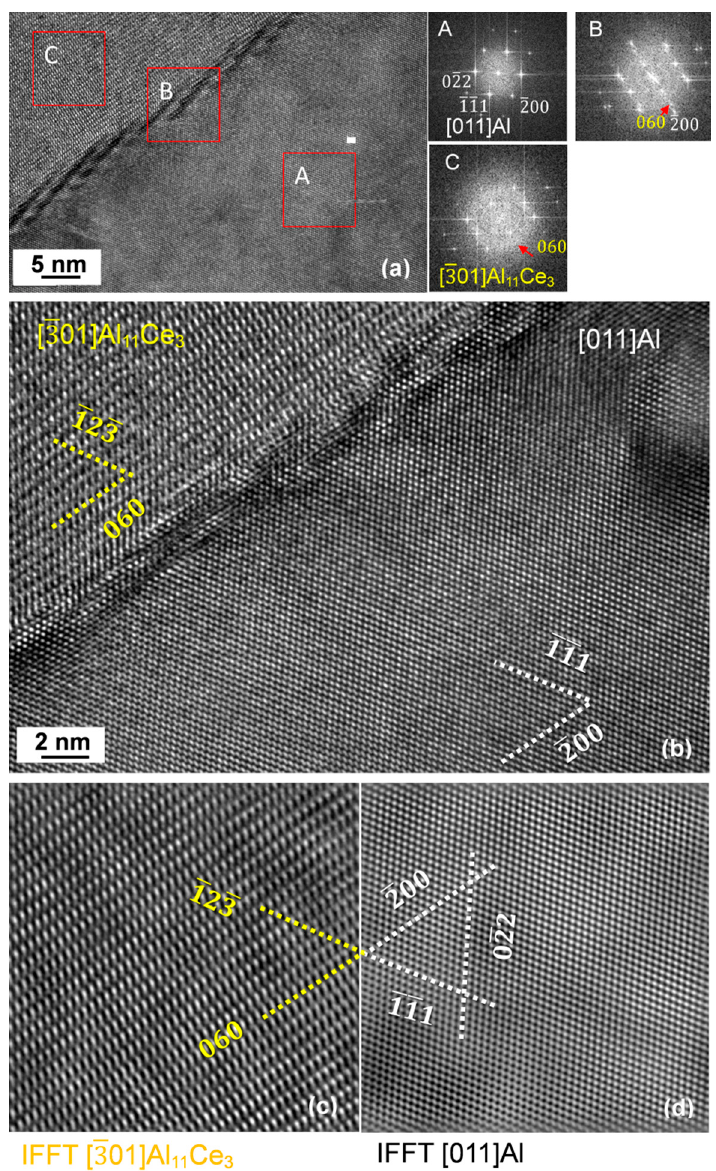
Figure 17. HRTEM images showing the structure of the Al 11 Ce 3 / Al interface within the eutectic: ( a ) interface with steps of high strain fields along with FFT patterns from the areas indicated; ( b ) fragment of the interface with atomic arrangements; ( c ) inverse fast Fourier transform image of the axis of Al 11 Ce 3 ; ( d ) inverse fast Fourier transform image of the [011] zone axis of Al.